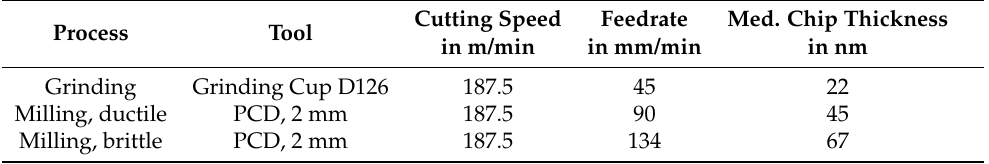
Table 5. Overview of the produced 3 samples—ground, milled and milled in a ductile cutting